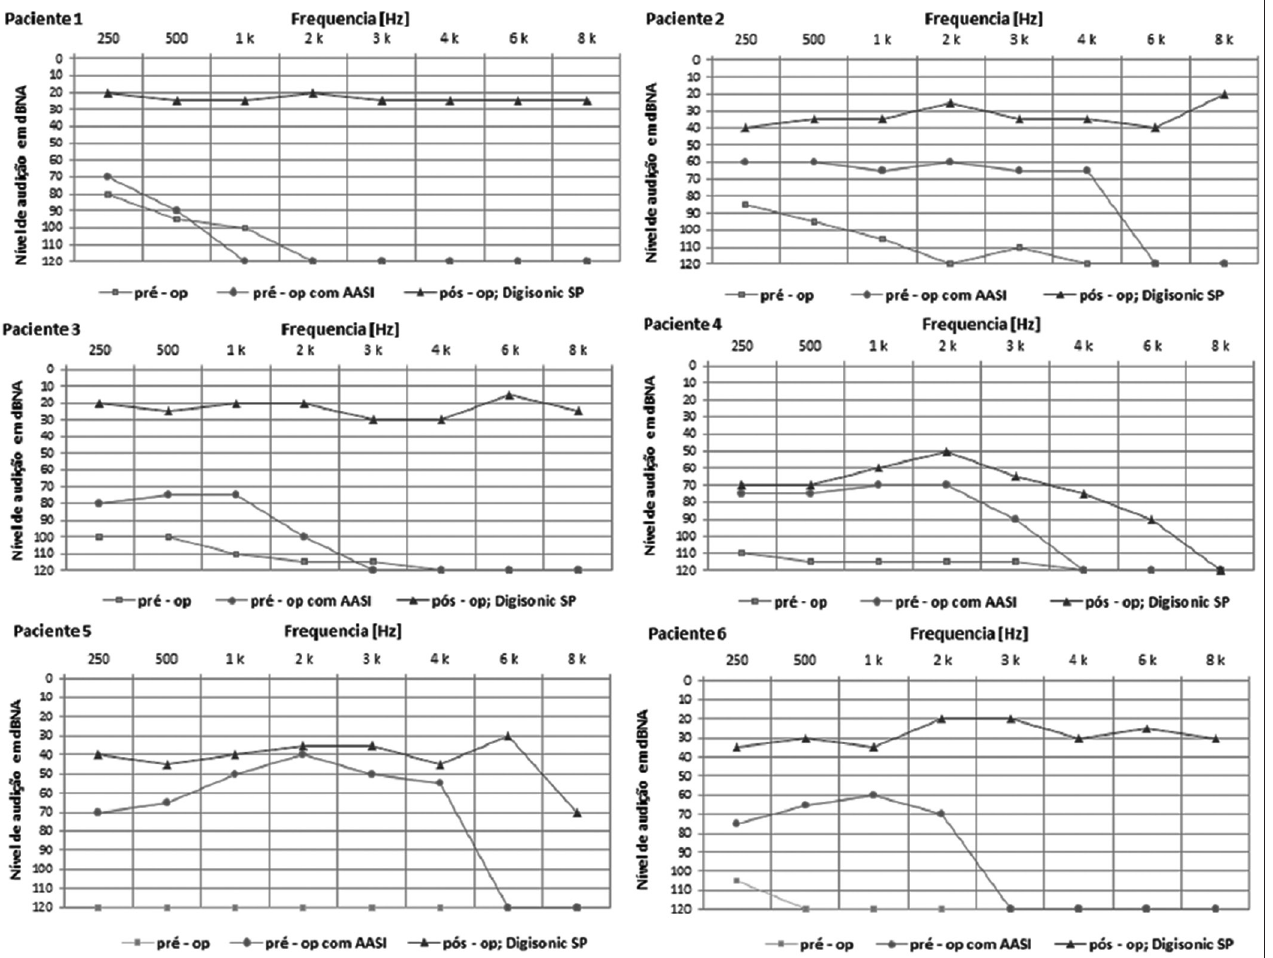
Figura 5. Imagem representa limiares audiométricos pré e pós-cirurgia de implante coclear dos seis casos com o Digisonic ® SP. Note a melhora do limiar nos